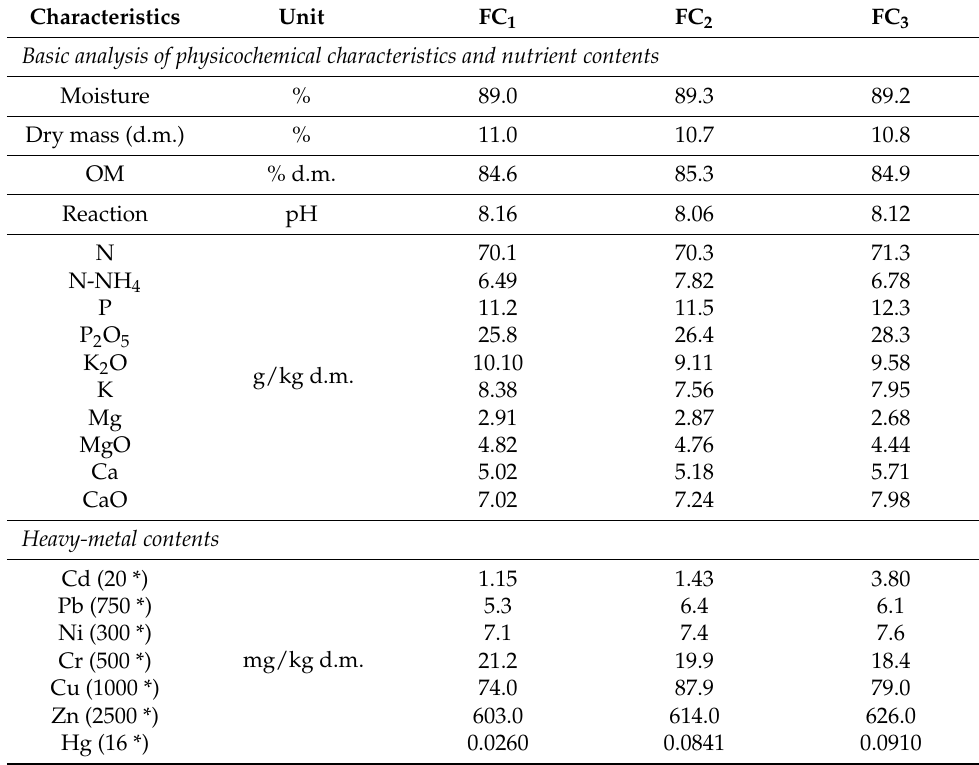
Table 1. Municipal sewage sludge